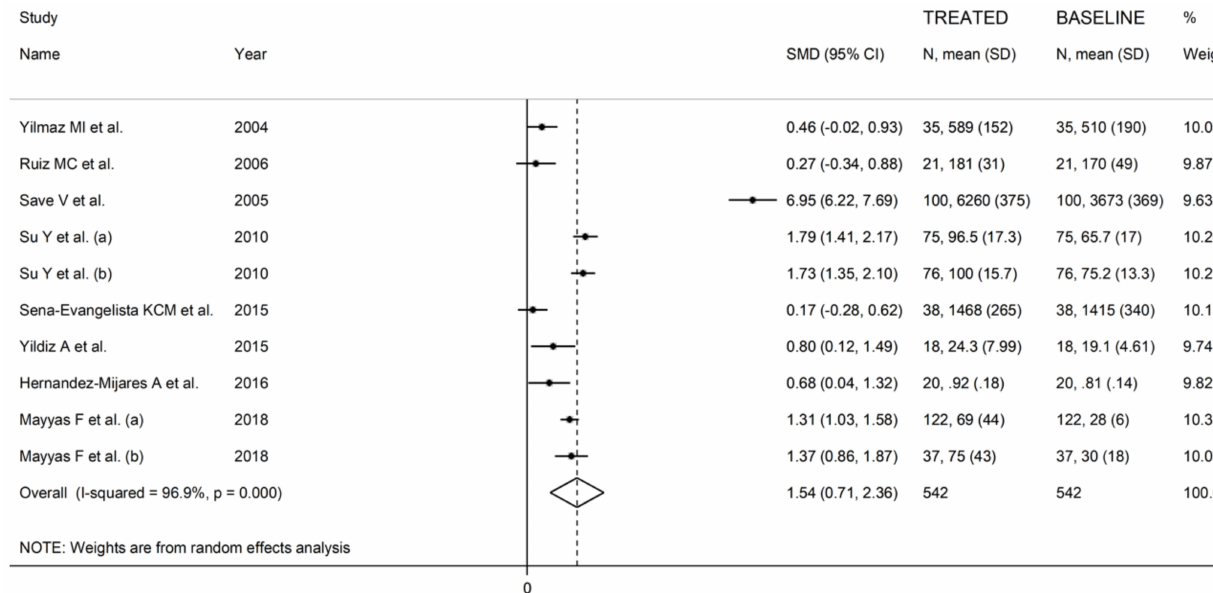
Figure 6. Forest plot of SOD concentrations before and after statin treatment.